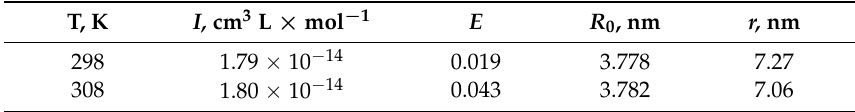
Table 5. The values of the overlap integral, the energy transfer efficiency, the Forster radius and the distance between the BSA and 4e